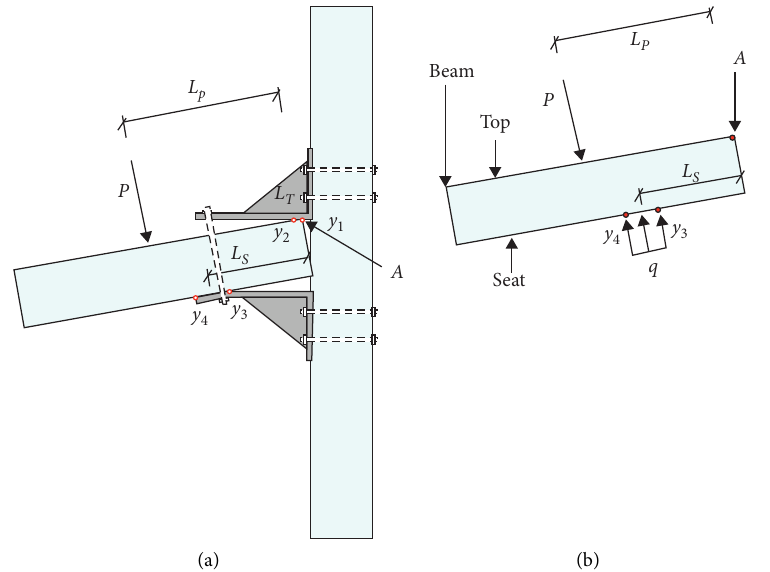
Figure 13: Calculation diagram of bearing capacity.